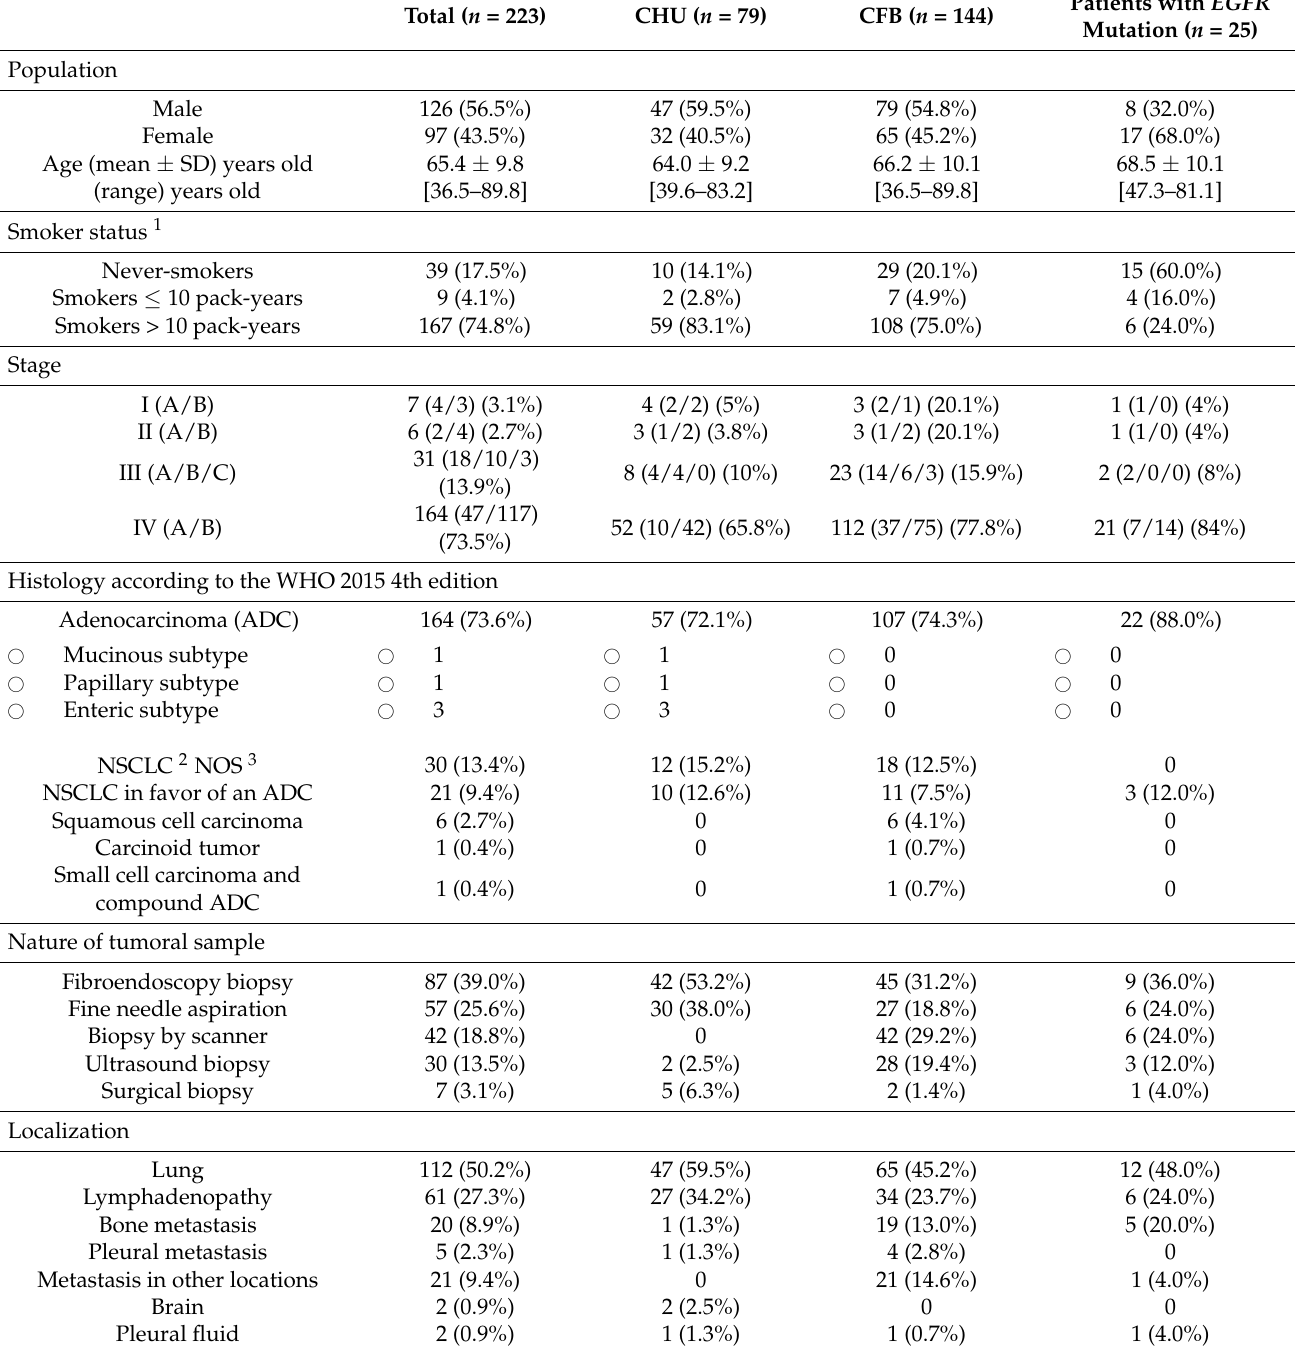
Table 1. Patients’